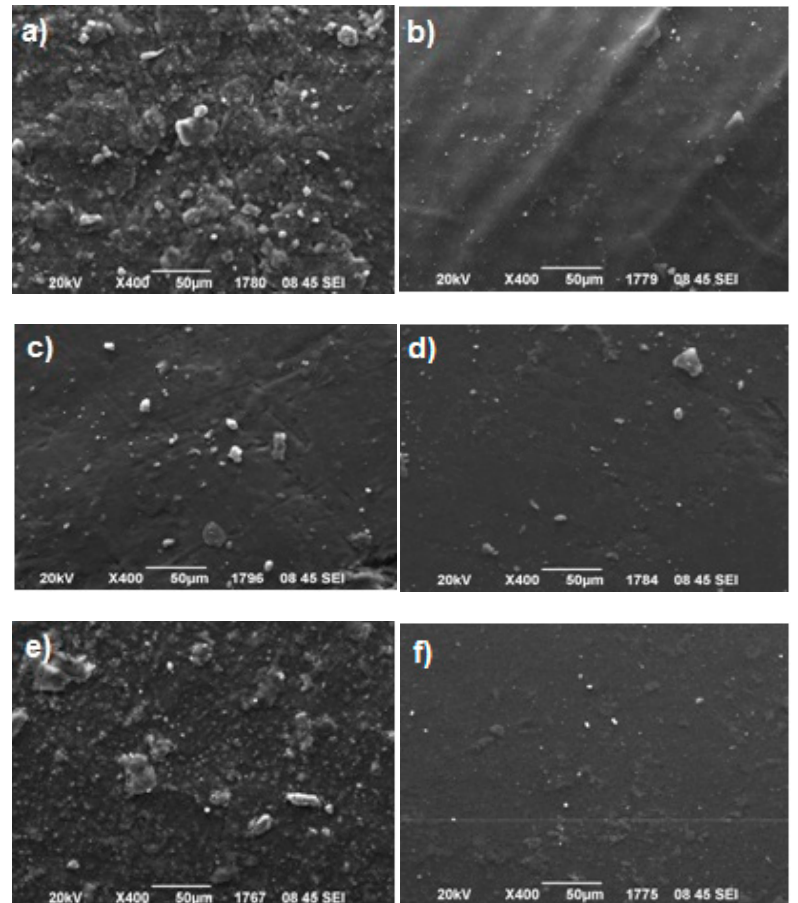
Figure 4. Scanning electron microscopy (SEM) images of a series of experimental dental